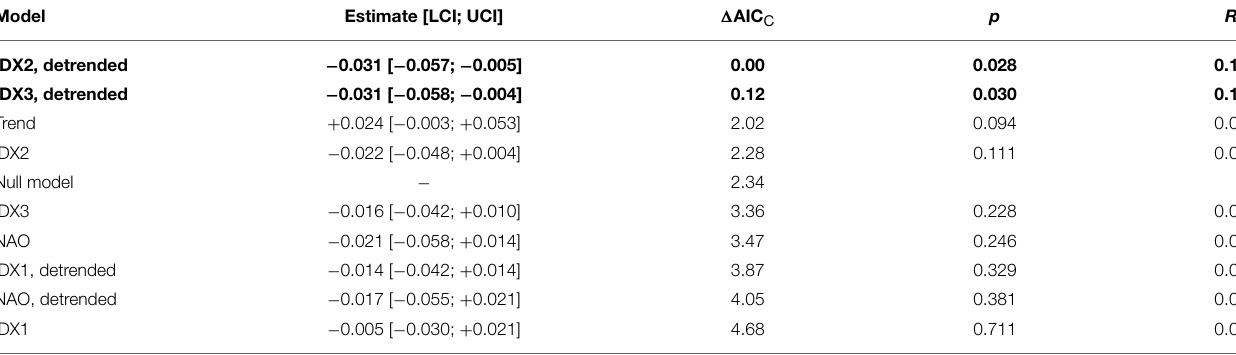
TABLE 2 | Stochastic population models of the Common Guillemot population on Hornøya. Model